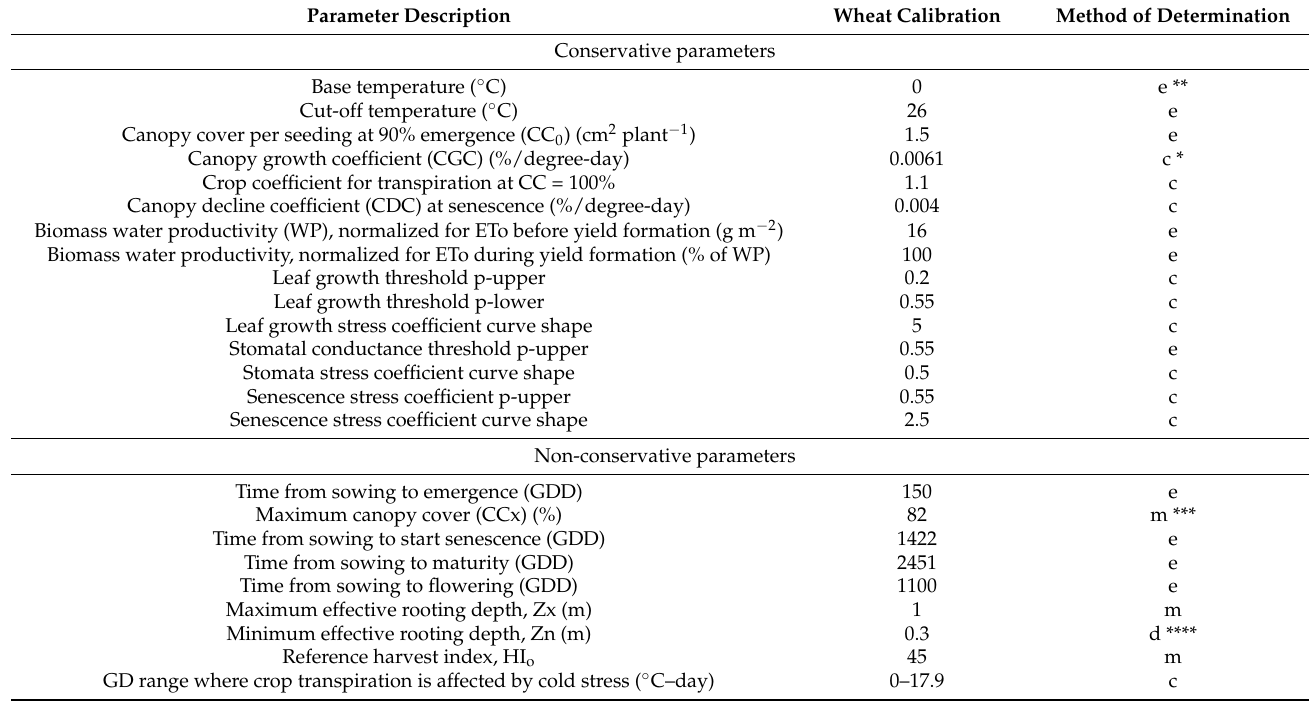
Table 3. Crop parameters used for wheat simulations by